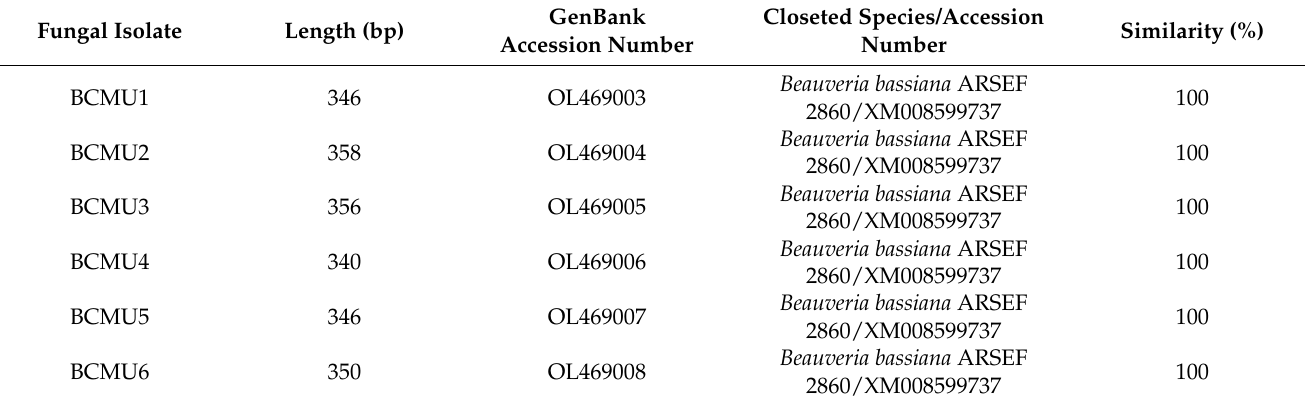
Table 4. Details of the GAS1 sequences obtained from entomopathogenic fungi in this study. Fungal